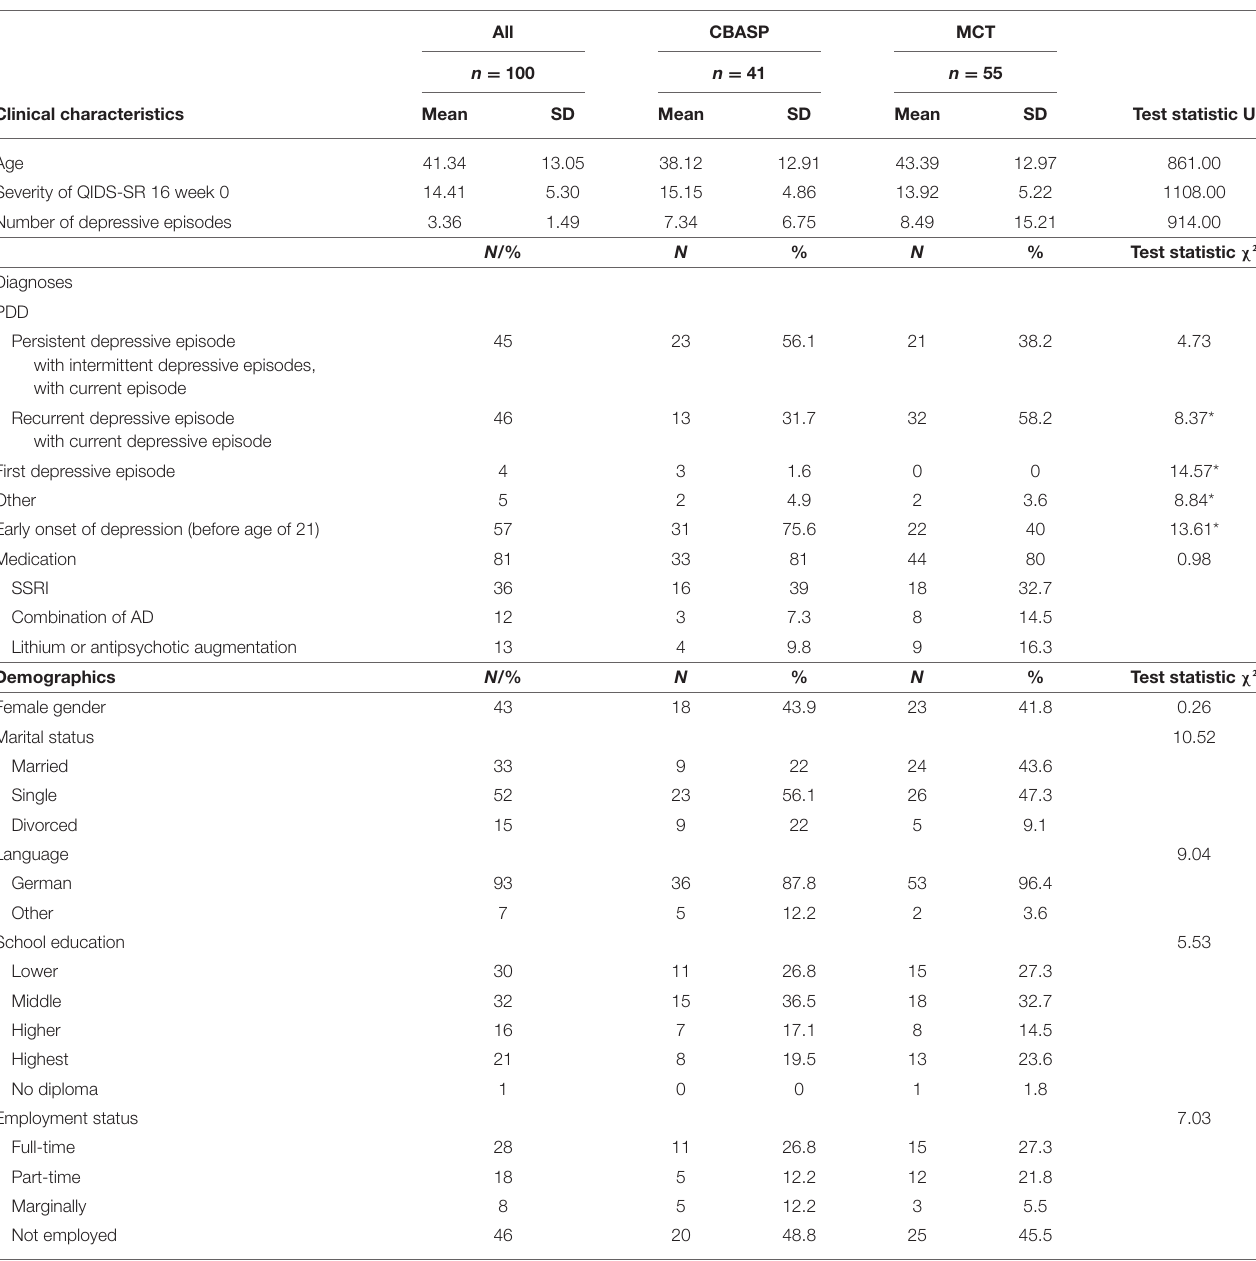
TABLE 1 | Clinical characteristics and